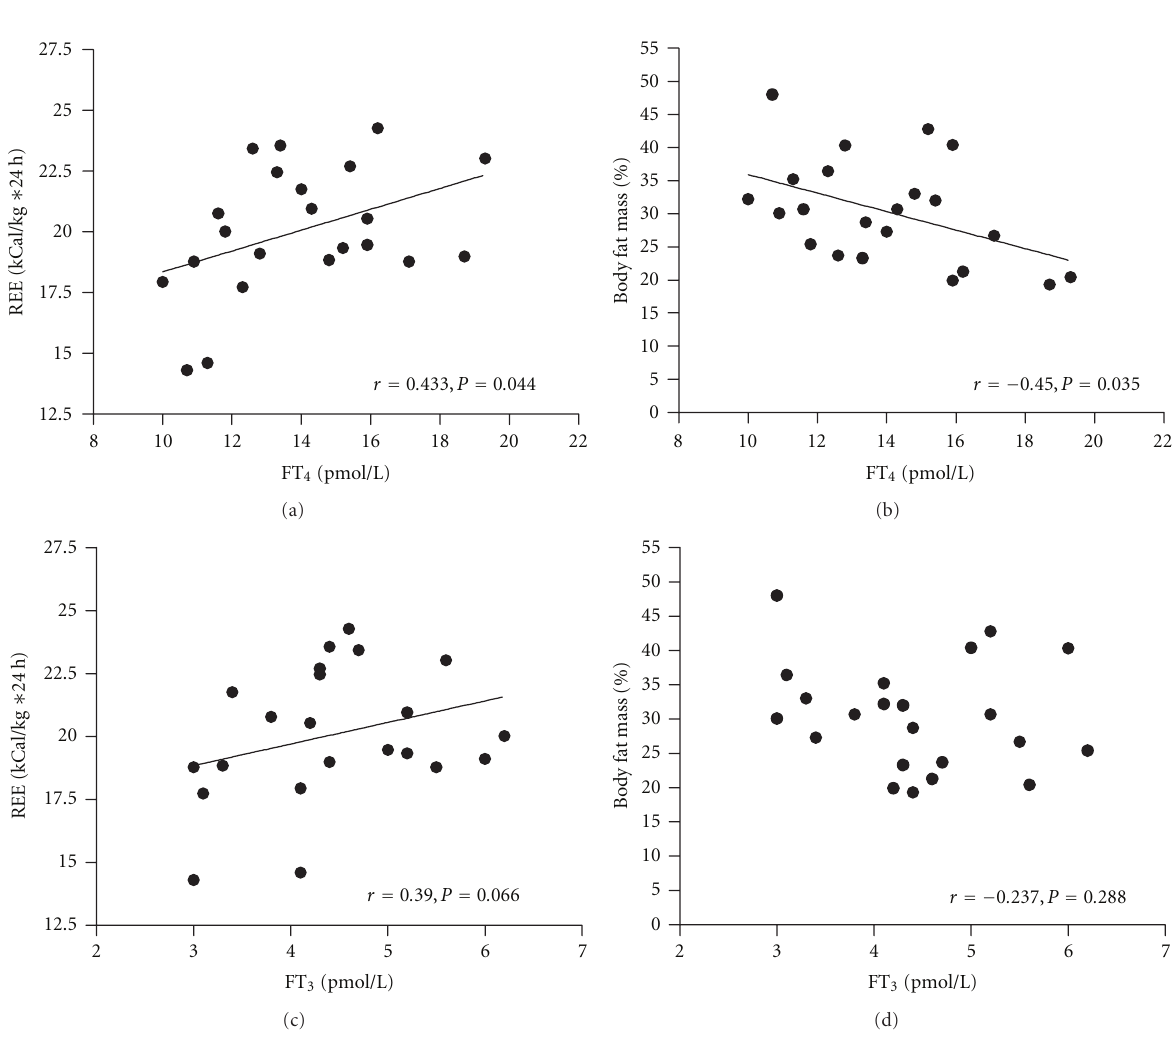
Figure 2: Correlations of serum FT 4 with resting energy expenditure (REE, (a)) and body fat mass (b), and serum FT 3 with REE (c) and body fat mass (d). Spearman’s correlation coe ffi cients ( r ) and P values are plotted under the horizontal axis of each